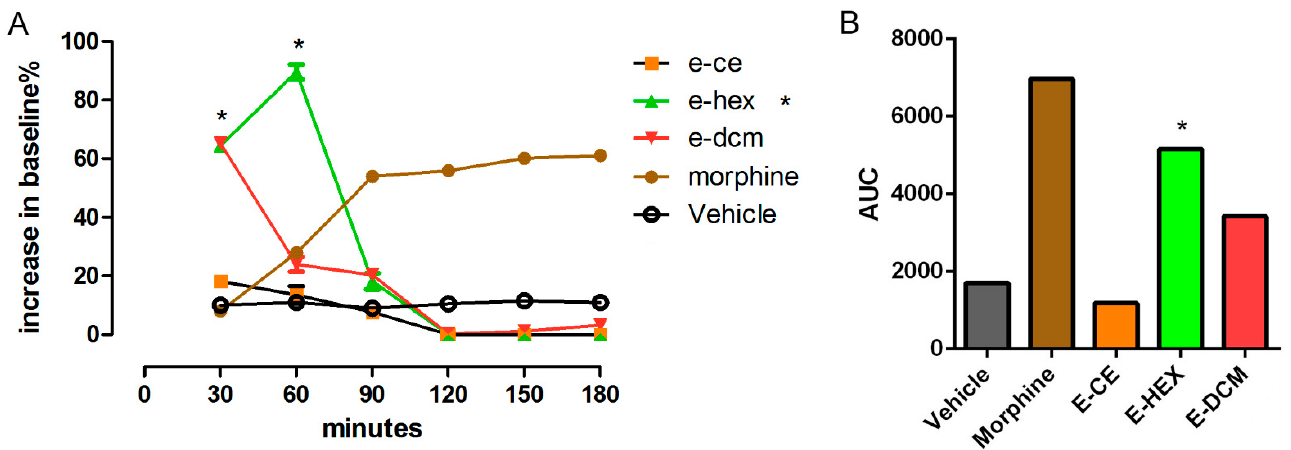
Figure 6. Effect of the crude ethanol extract of Elsholtzia ciliata and its fractions in hexane, dichloromethane, ethyl acetate and n-butanol on the hot plate test. Morphine was used as positive control ( A ). The result was also described as area under curve (AUC) of the crude ethanol extract of Elsholtzia ciliata and its fractions in hexane and dichloromethane on the hot plate test ( B ). Morphine was used as positive control. Statistical significance between groups (*) was calculated by analyses of variance (ANOVA), followed by Bonferroni’s test. p values less than 0.05 ( p ≤ 0.05) were used as the significant level.